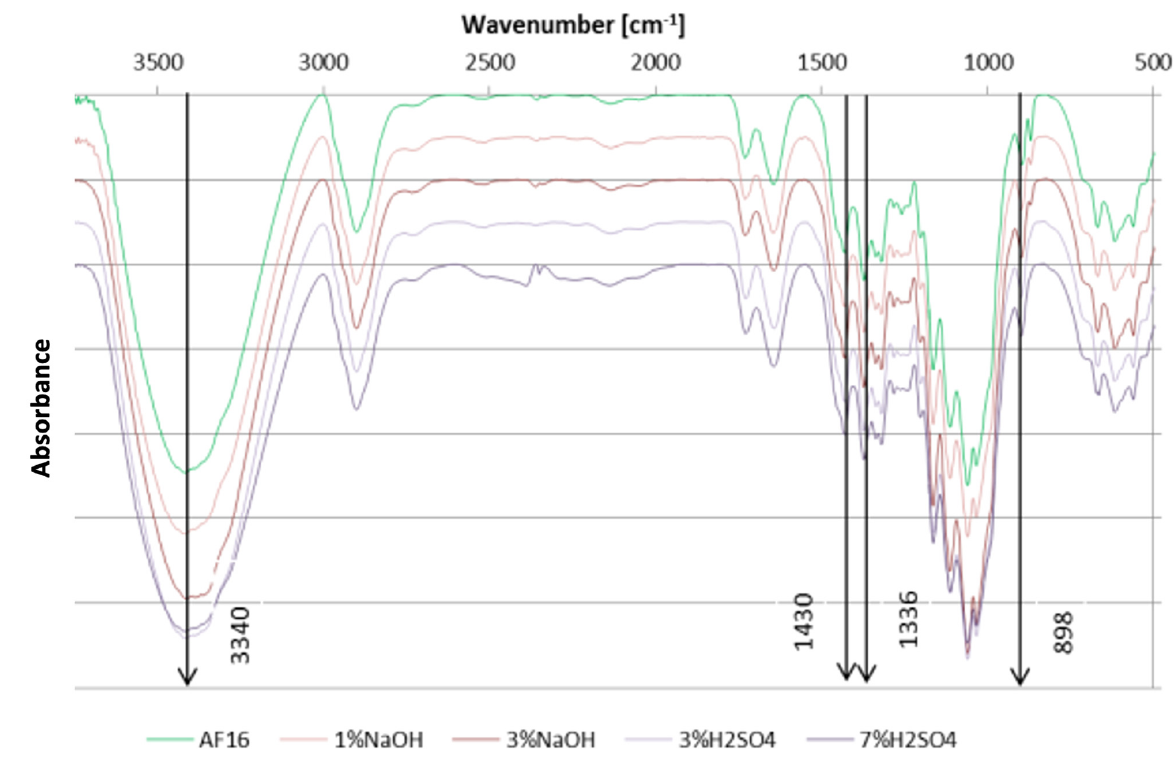
Figure 2. FTIR spectrum of poplar cellulose before and after pretreatment.